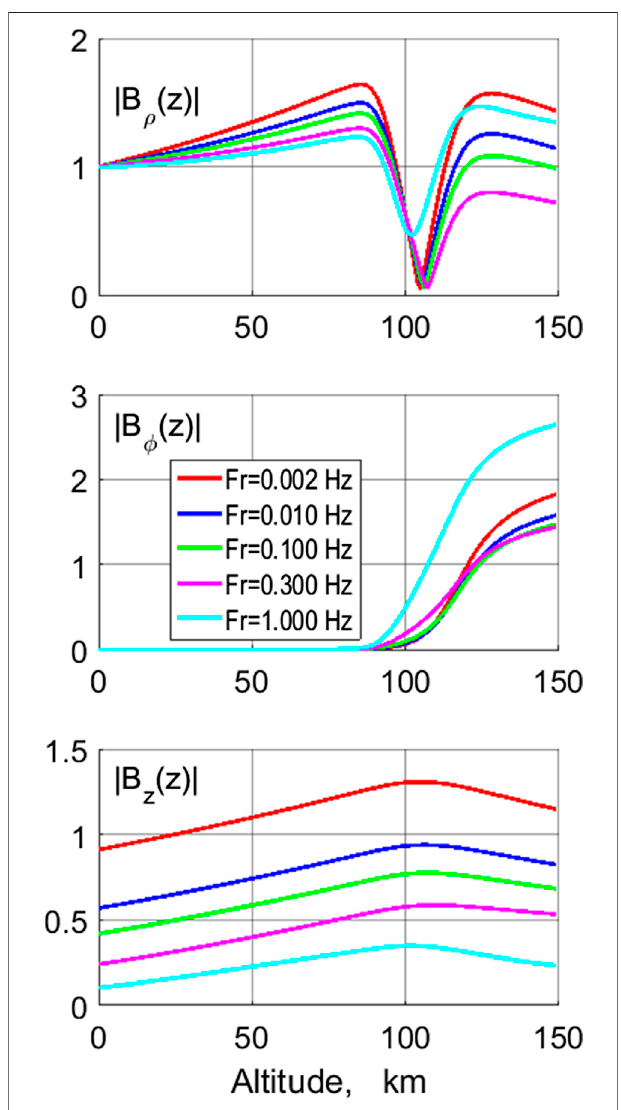
FIGURE 6 | The altitudinal pro fi les of the horizontal magnetic components (in nT) B ρ ( z ), B ϕ ( z ) at ρ (cid:2) ρ max and the vertical component B z ( z ) at ρ (cid:2) 0.